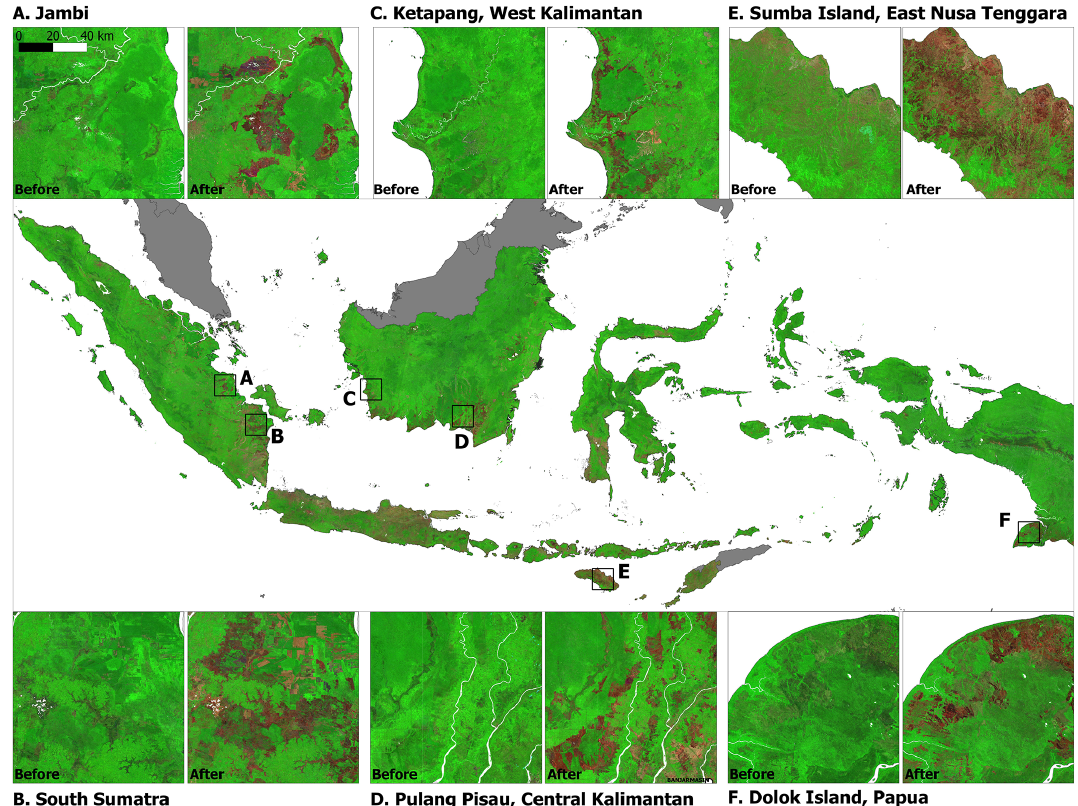
Figure 1. The pair of cloud-free pre-and post-fire Sentinel-2 composites shown over six locations in insets A, B, C, D, E, and F (all insets have the same scale). The base Indonesia-wide imagery is the post-fire composite. Imagery displayed in false colours (RGB: short-wave infrared, band 11; near infrared, band 8; blue: red, band 4). In this pair of composite images acquired shortly before and after fire, a recently burned area will readily appear to have transitioned from “green” to dark “brown/red” tones. Areas cleared without burning appear bright pink. Areas covered with vegetation appear dark to bright green.